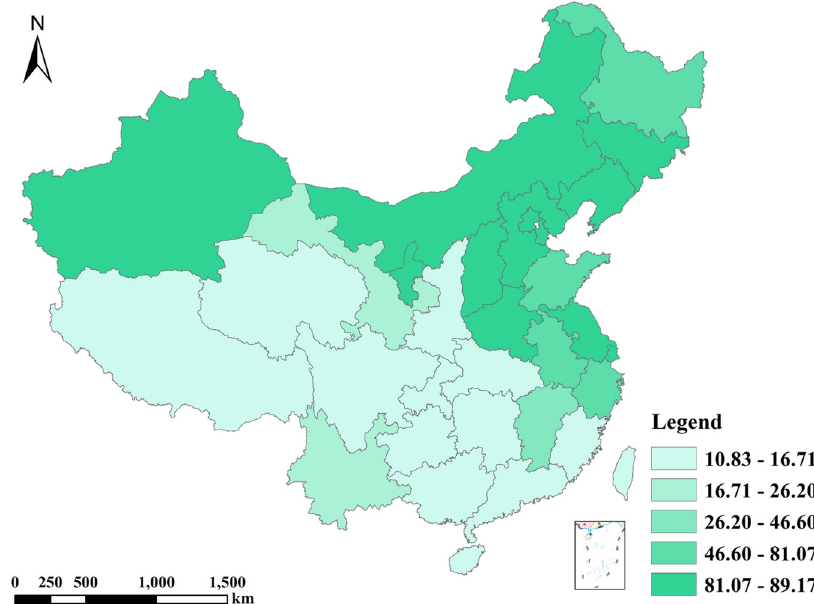
Fig. 5 Rice quality – heavy metal(loid) (RQHM) score distribution. [Note: the shade of green is used to represent the RQHM score. The darker the green, the higher the